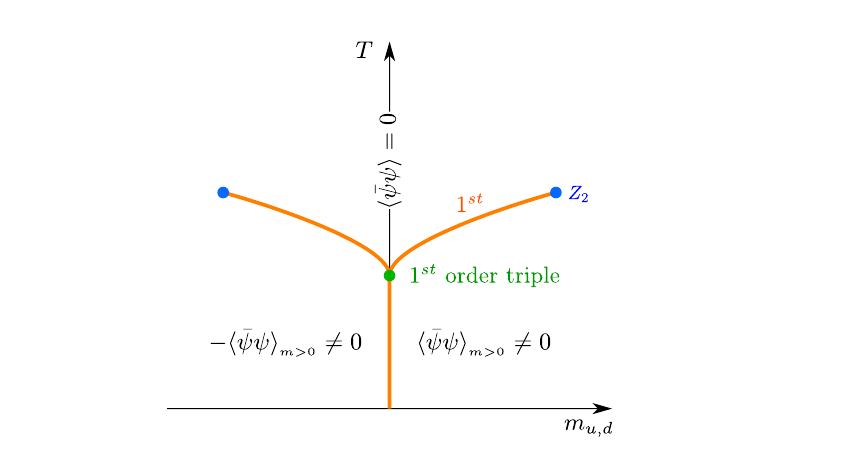
Figure 3. Sketch of the T − m u,d phase diagram. The temperature axis with T < T c corresponds to a first-order coexistence line of ±h ¯ ψψ i 6 = 0 , and T c ( m u,d = 0) represents a triple